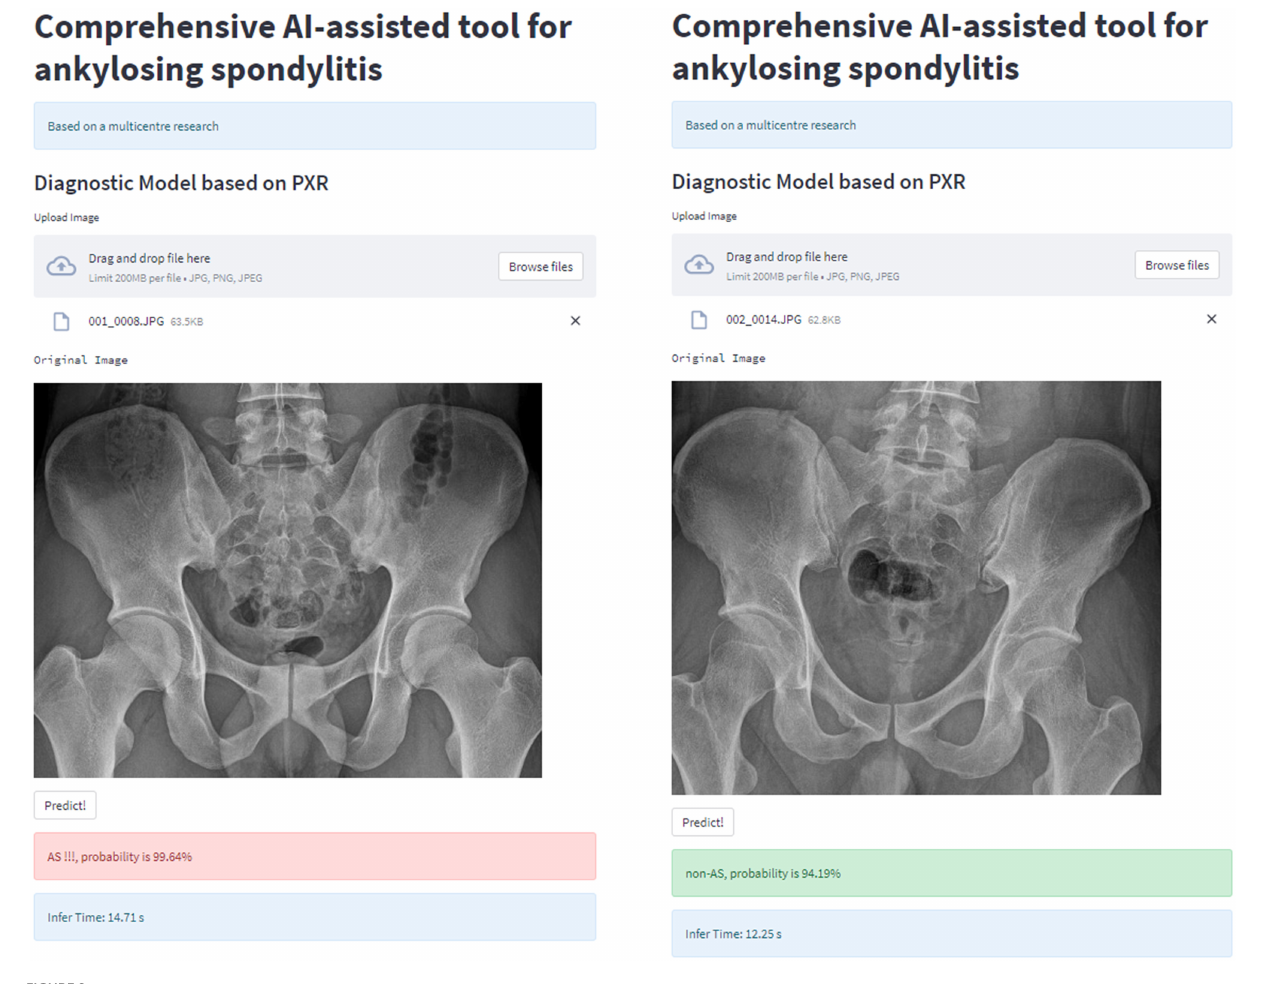
FIGURE9 AI-assisted system